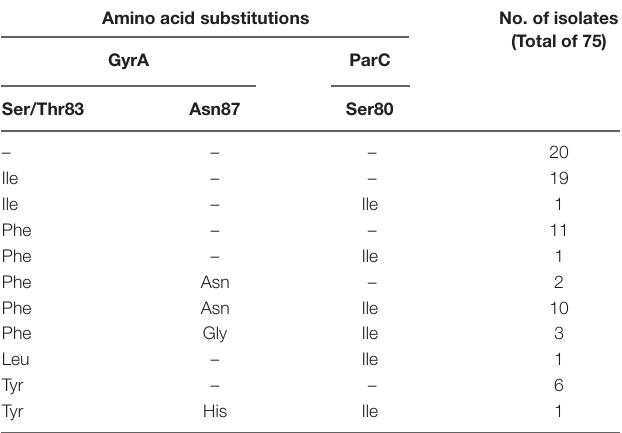
TABLE 3 | Mutations observed in QRDR of E. cloacae isolates. TABLE 4 | Prevalence of QRDR mutations in PMQR-carrying and PMQR negative E. cloacae isolates a